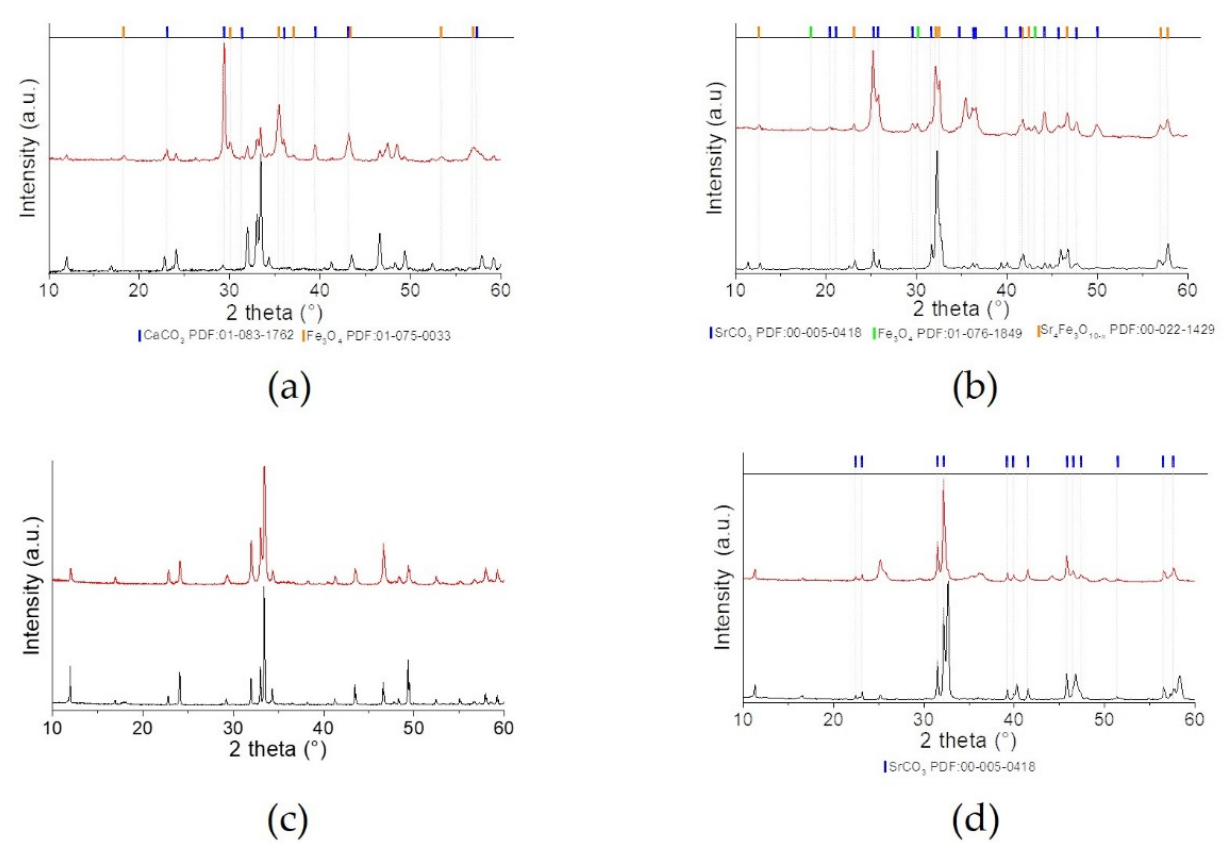
Figure 6. XRD patterns of ( a ) CFO_cp, ( b ) SFO_cp, ( c ) CFO_eaf and SFO_eaf ( d ) as-synthesized (black pattern) and after ILPOR test (red pattern).